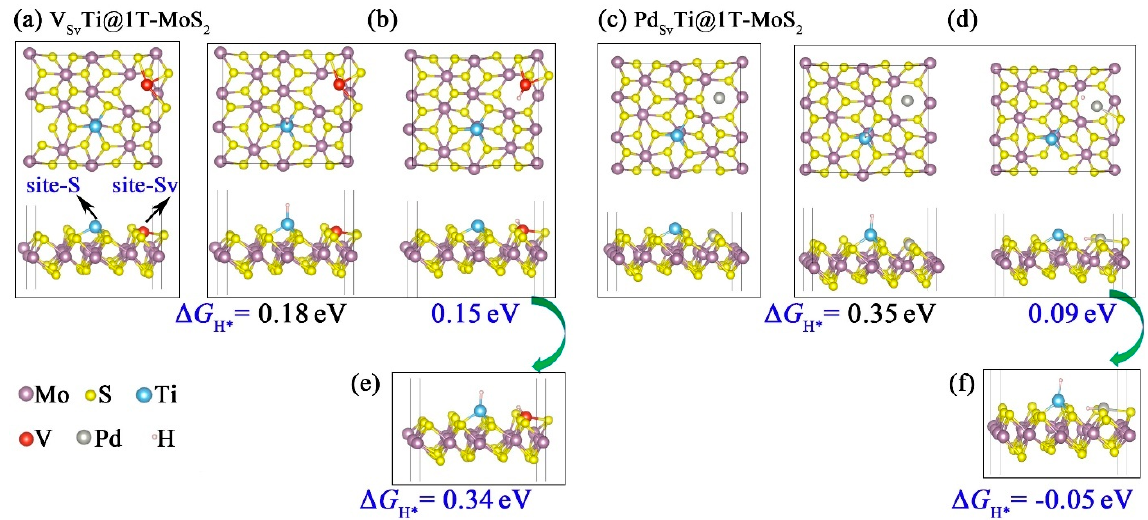
Figure 6. Top and side views of optimized ( a ) V Sv Ti@1T-MoS 2 and ( b ) one H adsorption on V Sv Ti@1T-MoS 2 . Top and side views of optimized ( c ) Pd Sv Ti@1T-MoS 2 and ( d ) one H adsorption on Pd Sv Ti@1T-MoS 2 . ( e ) Two H adsorption on V Sv Ti@1T-MoS 2 . ( f ) Two H adsorption on Pd Sv Ti@1T-MoS 2 .